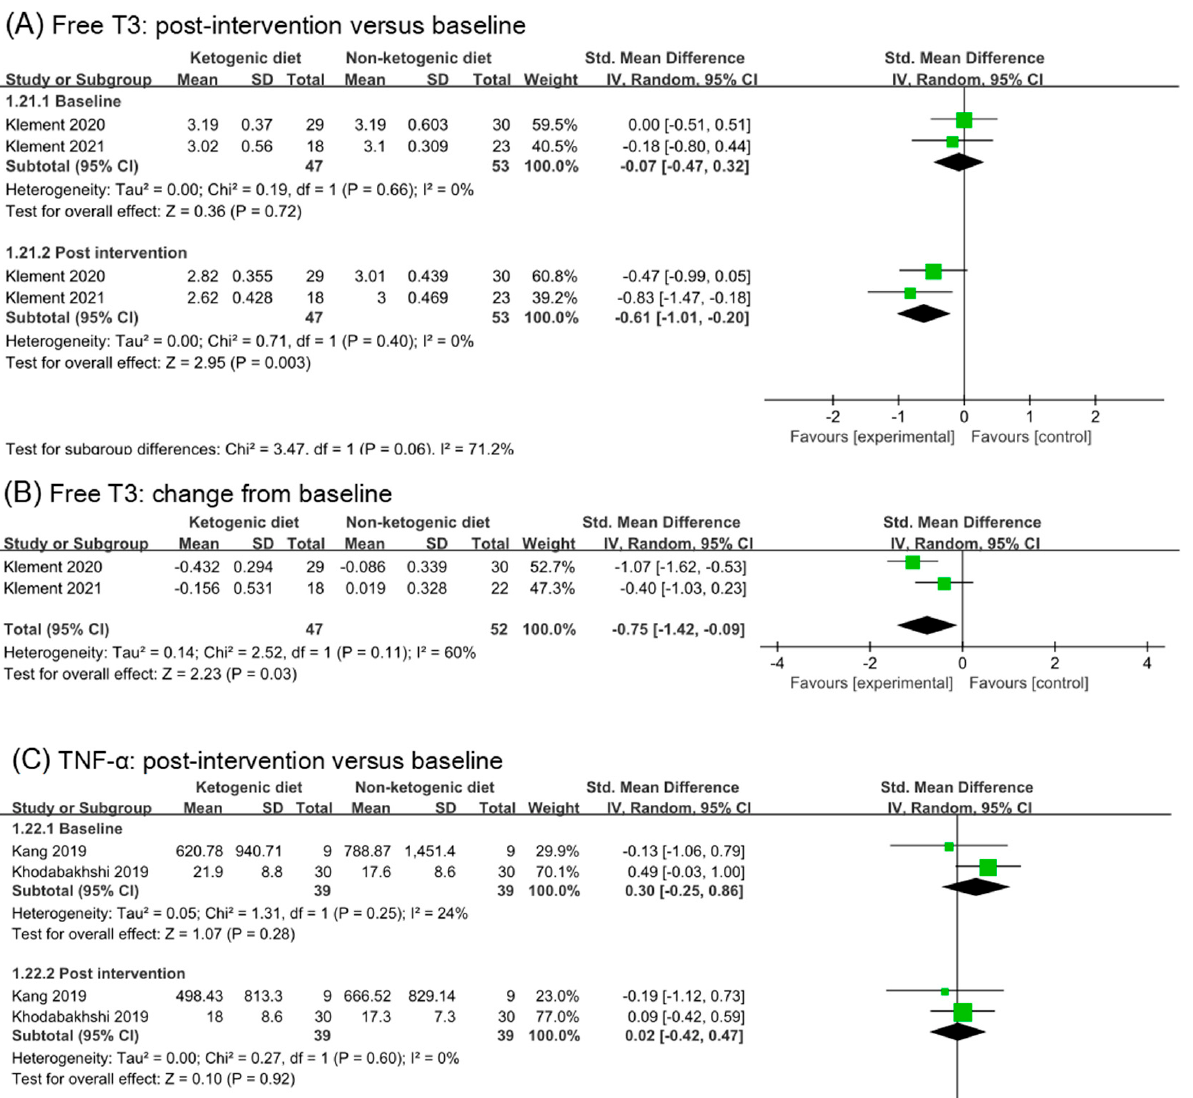
19 of 25 Figure 8. Forest plot for the effects of ketogenic diets on liver function. ( A – D ) were subgroup effects of the baseline versus post-intervention on ALT, AST, albumin, and GGT [31–33,36,37,40–42]. 3.10. Free T3 and TNF- α Two studies were included in analysis of free T3 and TNF- α (Figure 9). The effect size in baseline and post intervention was (SMD − 0.07, 95% CI − 0.47 to 0.32) and (SMD − 0.61,